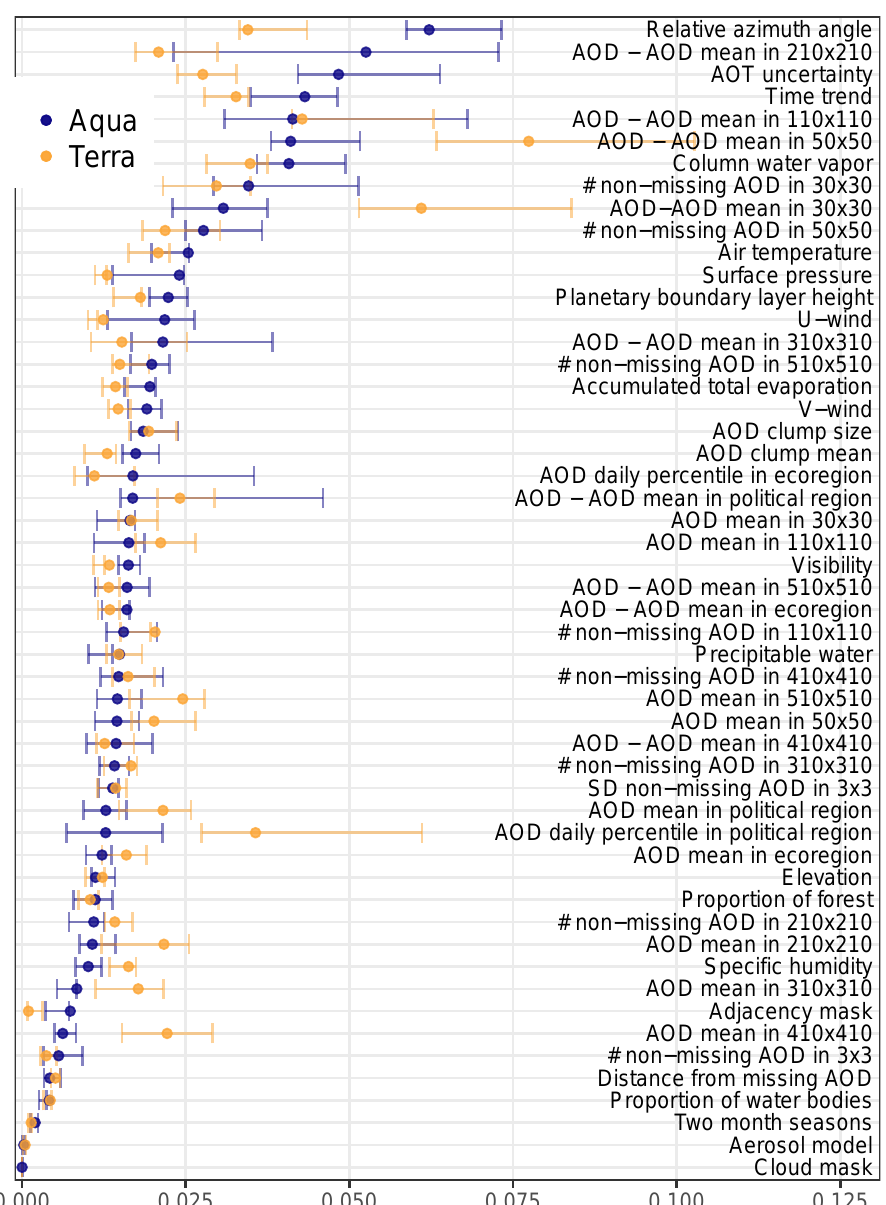
Figure 4. Variable importance predicting measurement error by node impurity from XGBoost for the Aqua and Terra dataset with intervals showing the range of variable importance measures across ten bootstrap-resampling fits of the training